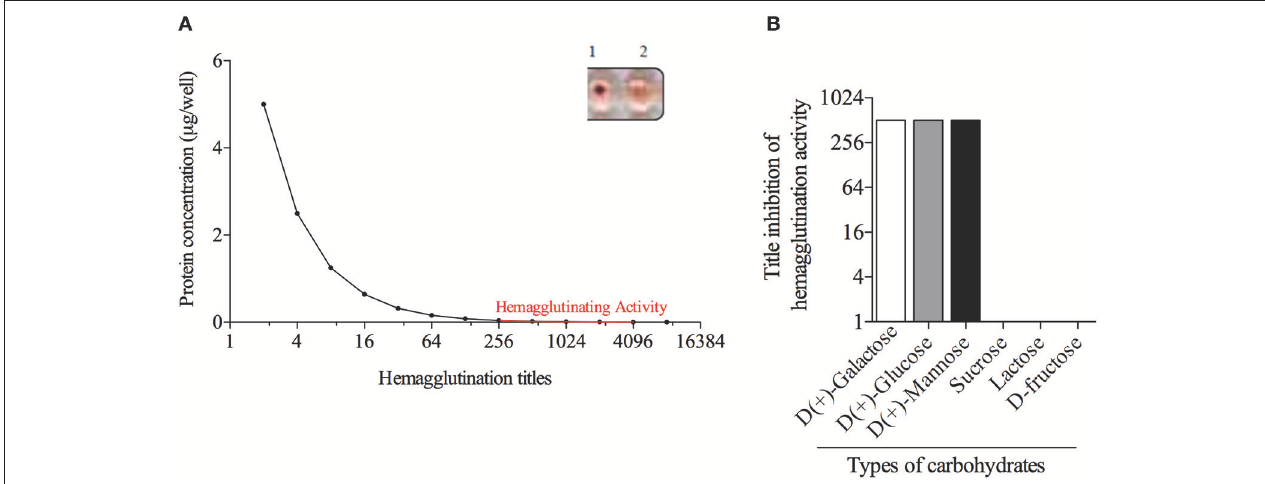
FIGURE 2 | Bidens pilosa acetonic fraction has hemagglutination activity. (A) Dilutions of Bidens pilosa protein was added to human erythrocytes suspensions. Aspect of the hemagglutination assay showing negative reaction (1) and positive reaction (2). Representative results from two independent experiments. (B) Inhibition of hemagglutination activity of Bidens pilosa acetonic fraction by six carbohydrates: [D( + )-Galactose, D( + )-Glucose, D( + )-Mannose, sucrose, lactose, and D-fructose]. Hemagglutination activity inhibition was observed by D( + )-Galactose, D( + )-Glucose and D( + )-Mannose. Representative results from two independent experiments.